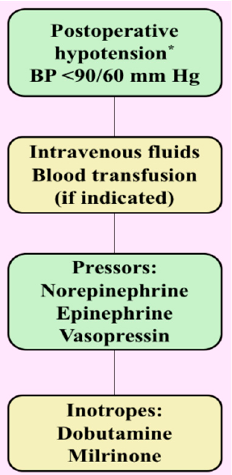
Figure 2. Postoperative management of hypotension following tumor resection. * In the differential diagnosis of hypotension consider downregulation of adrenoceptors, cardiogenic shock, sepsis, and medication-induced. BP, blood pressure.